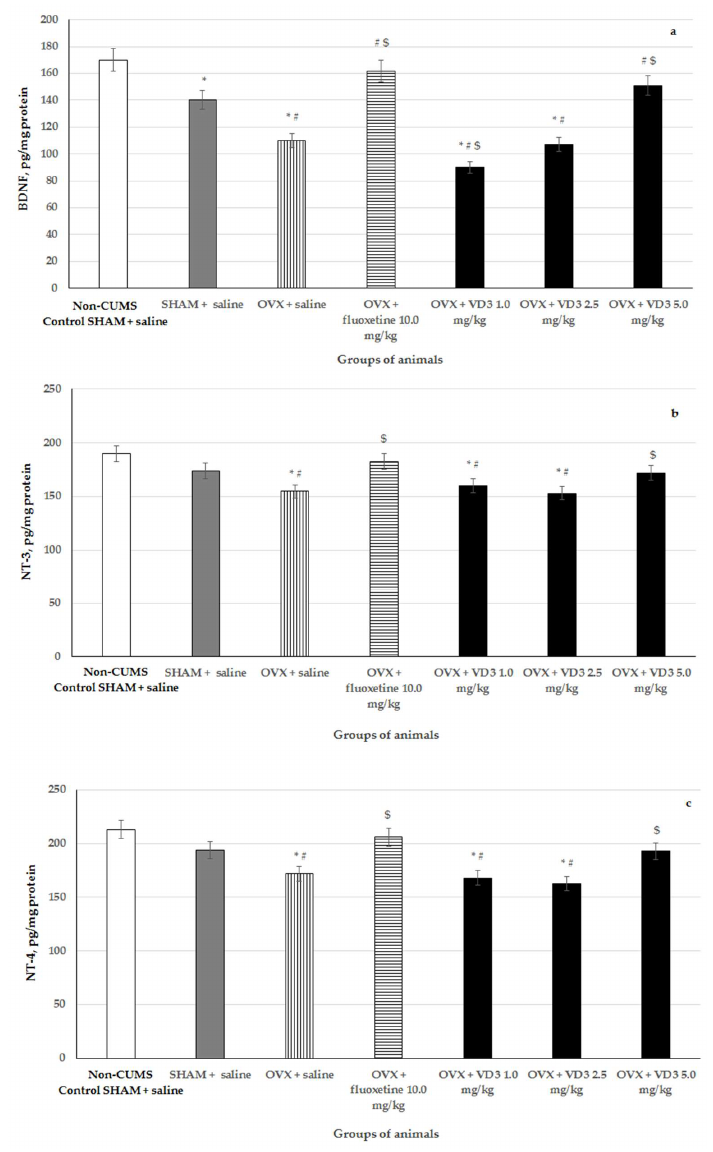
Figure 7. E ff ects of VD 3 administered in various doses on hippocampal BDNF ( a ), NT-3 ( b ), and NT-4 ( c ) concentrations in the long-term OVX rats subjected to CUMS. *— p < 0.05 versus the non-CUMS SHAM group (control group) treated with saline, #— p < 0.05 versus the SHAM group with CUMS treated with saline, $— p < 0.05 versus the long-term OVX group with CUMS treated with saline. The data are presented as the mean ± SD; n = 7 in each group.